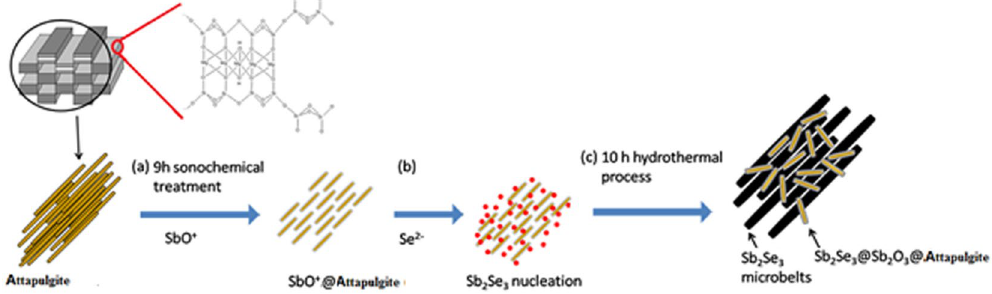
Figure 1. Schematic diagram of a synthesis strategy of the Sb 2 Se 3 /Sb 2 O 3 @attapulgite